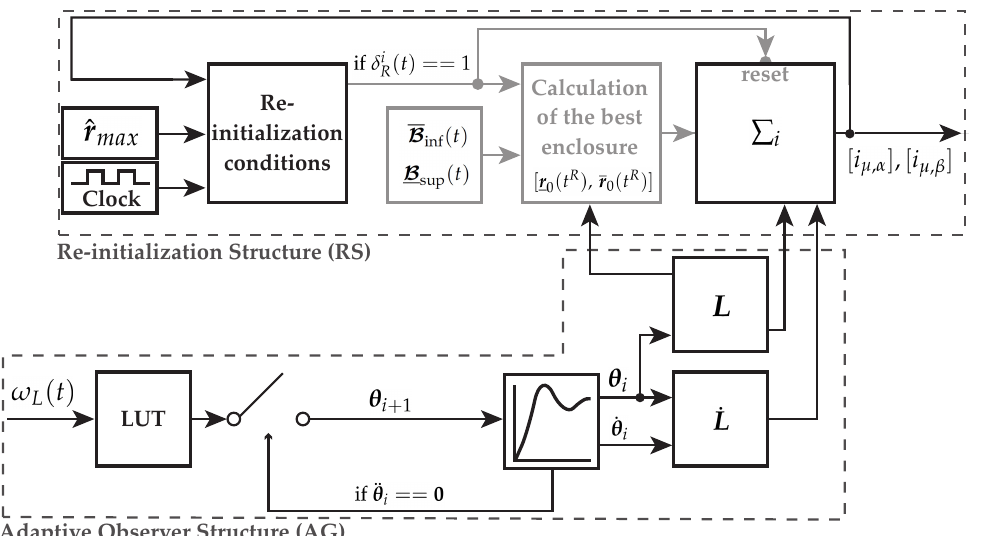
Figure 8. Extensions of the interval observer: Re-initialization structure (RS) and the adaptive observer gain (AG) selecting the optimal observer parametrization θ from a lookup table (LUT) depending on ω L ( t ) . After the LTI (linear time invariant) switching function (67), the observer gain L as well as its derivative ˙ L are set up for the reduced-order interval